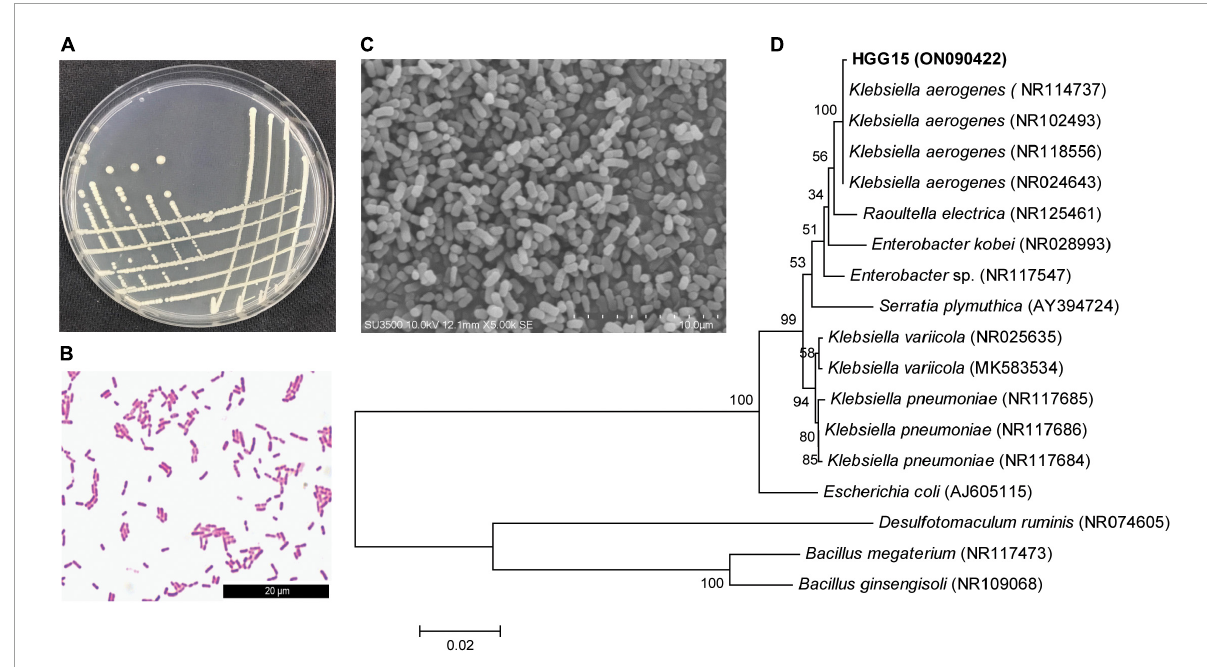
FIGURE3 Characterization of Klebsiella sp. HGG15 strain. (A) Colony feature on LB medium after 24 h. (B) Gram-positive staining. (C) Scanning electron microscopy of bacterial cells. (D) Phylogenetic tree based on 16S rDNA. The tree was constructed by MEGA 6.0 using neighbor-joining analysis of 1,000 bootstrap replications.